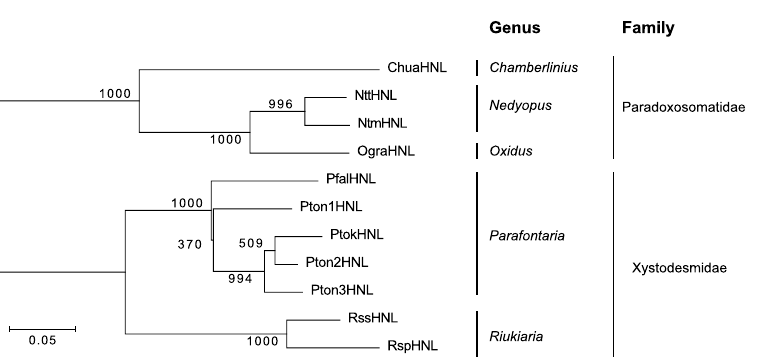
Figure 3. Phylogenetic analysis of HNLs from cyanogenic millipedes. Phylogenetic tree was constructed by the neighbor-joining method with 1000 bootstrap replicates. Bar indicates 5% divergence.